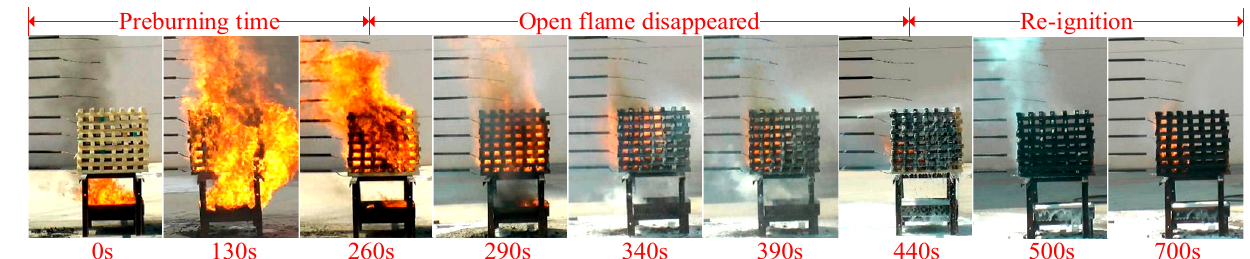
Figure 9. Fire extinguishing process images: foam extinguishing agent. Figure 10 shows the variation in the temperature during fire extinction experiments.